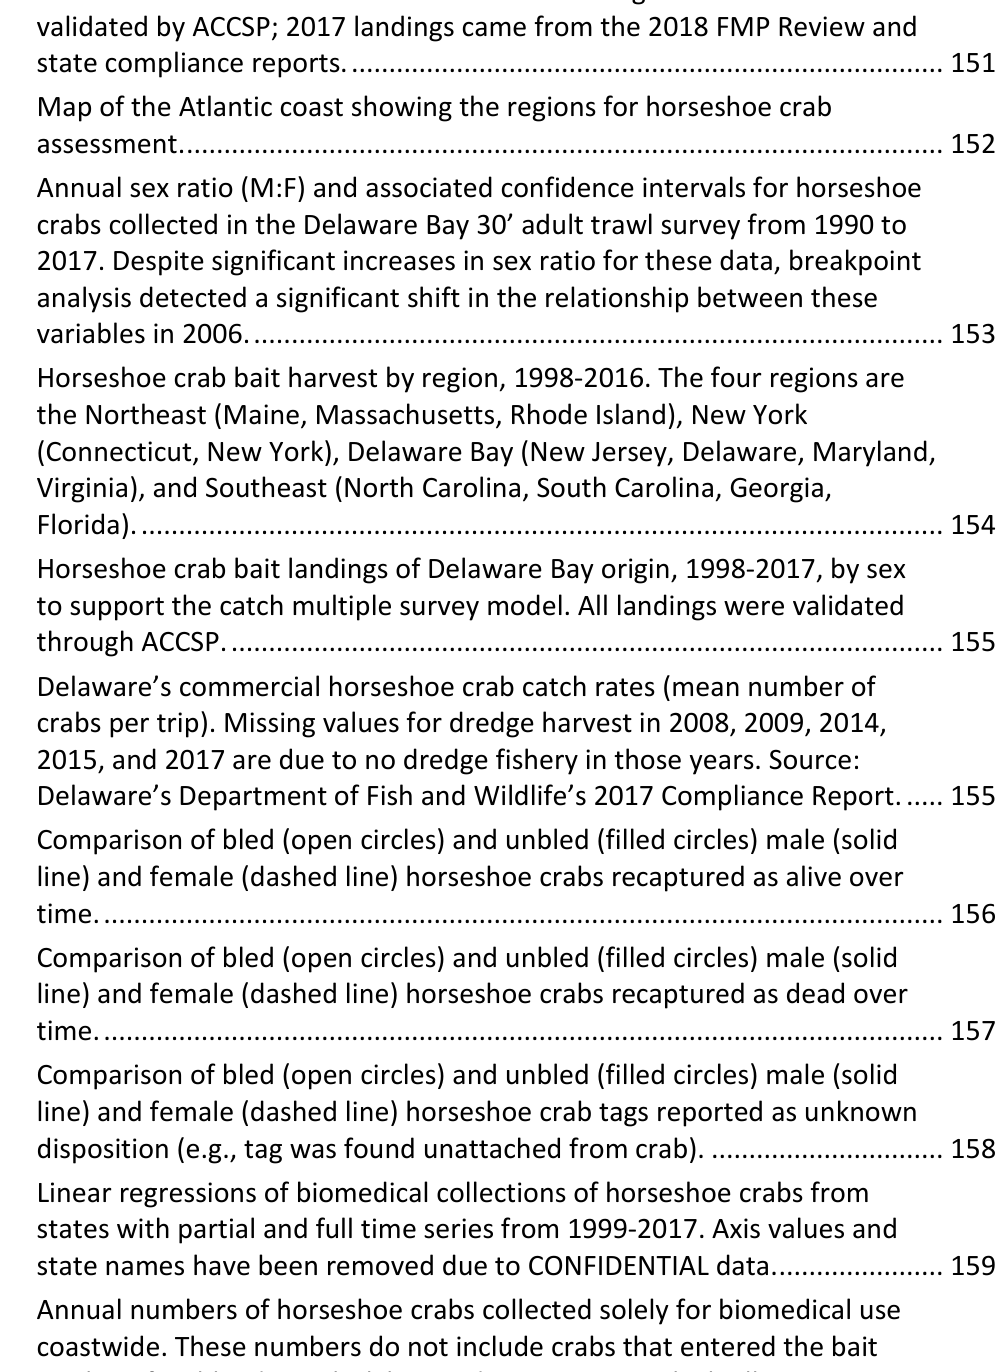
Figure 1. Coastwide horseshoe crab bait landings, 1998-2017, in numbers and by sex. Not every state along the Atlantic coast provides comprehensive sex data and therefore some are unclassified. Landings from 1998-2016 were validated by ACCSP; 2017 landings came from the 2018 FMP Review and Figure 2. Map of the Atlantic coast showing the regions for horseshoe crab Figure 3. Annual sex ratio (M:F) and associated confidence intervals for horseshoe crabs collected in the Delaware Bay 30’ adult trawl survey from 1990 to 2017. Despite significant increases in sex ratio for these data, breakpoint analysis detected a significant shift in the relationship between these Figure 4. Horseshoe crab bait harvest by region, 1998-2016. The four regions are the Northeast (Maine, Massachusetts, Rhode Island), New York (Connecticut, New York), Delaware Bay (New Jersey, Delaware, Maryland, Virginia), and Southeast (North Carolina, South Carolina, Georgia, Figure 5. Horseshoe crab bait landings of Delaware Bay origin, 1998-2017, by sex to support the catch multiple survey model. All landings were validated Figure 6. Delaware’s commercial horseshoe crab catch rates (mean number of crabs per trip). Missing values for dredge harvest in 2008, 2009, 2014, 2015, and 2017 are due to no dredge fishery in those years. Source: Delaware’s Department of Fish and Wildlife’s 2017 Compliance Report. ..... 155 Figure 7. Comparison of bled (open circles) and unbled (filled circles) male (solid line) and female (dashed line) horseshoe crabs recaptured as alive over Figure 8. Comparison of bled (open circles) and unbled (filled circles) male (solid line) and female (dashed line) horseshoe crabs recaptured as dead over Figure 9. Comparison of bled (open circles) and unbled (filled circles) male (solid line) and female (dashed line) horseshoe crab tags reported as unknown disposition (e.g., tag was found unattached from crab). ............................... 158 Figure 10. Linear regressions of biomedical collections of horseshoe crabs from states with partial and full time series from 1999-2017. Axis values and Figure 11. Annual numbers of horseshoe crabs collected solely for biomedical use coastwide. These numbers do not include crabs that entered the bait market after bleeding. Black bars indicate years in which all